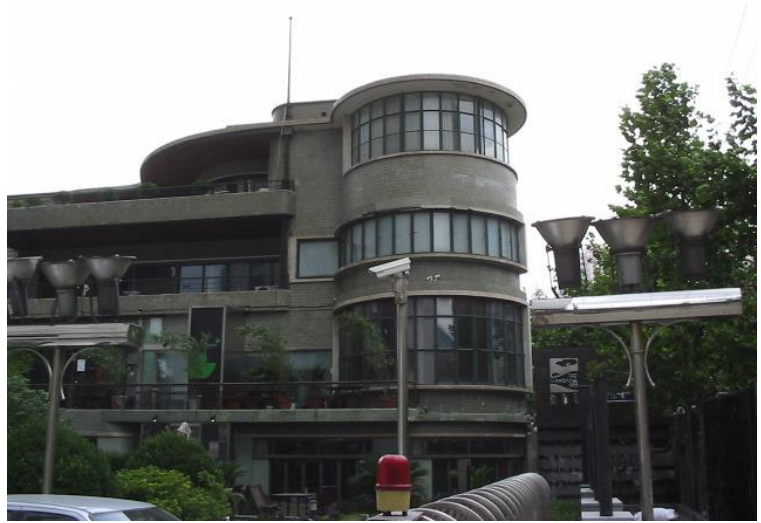
Figure 13. Former residence of Dr. Woo.